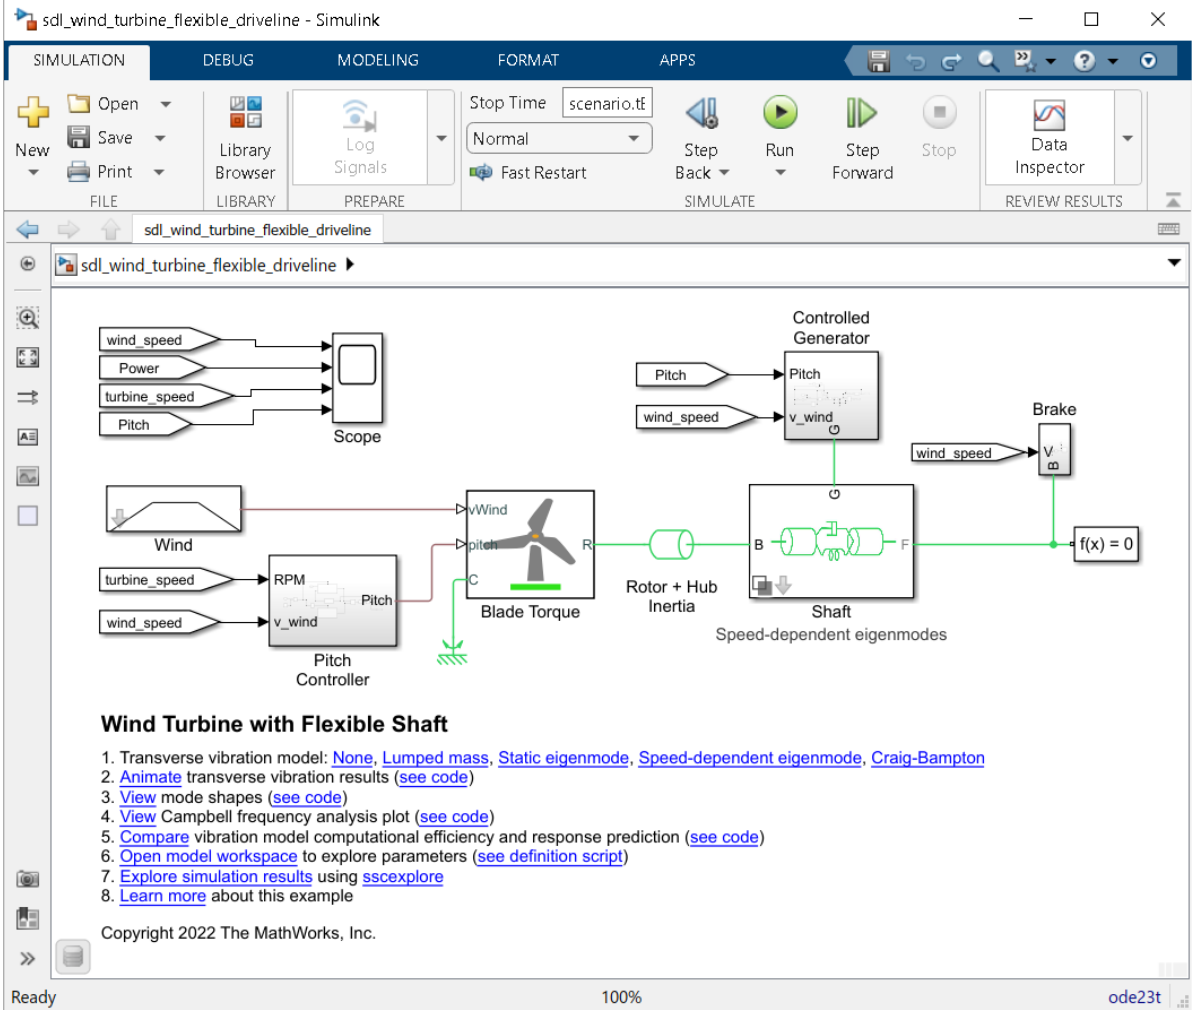
Figure 3. Simscape ™ Driveline ™ simulation model of a fluid-film-bearing-supported 10 MW direct- Figure 3. Simscape™ Driveline™ simulation model of a fluid-film-bearing-supported 10 MW direct- drive wind turbine drive shaft. drive wind turbine drive